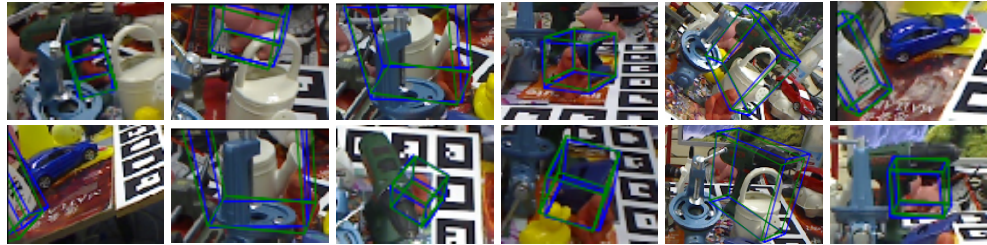
Figure 7. Comparison between predicted and ground truth pose.